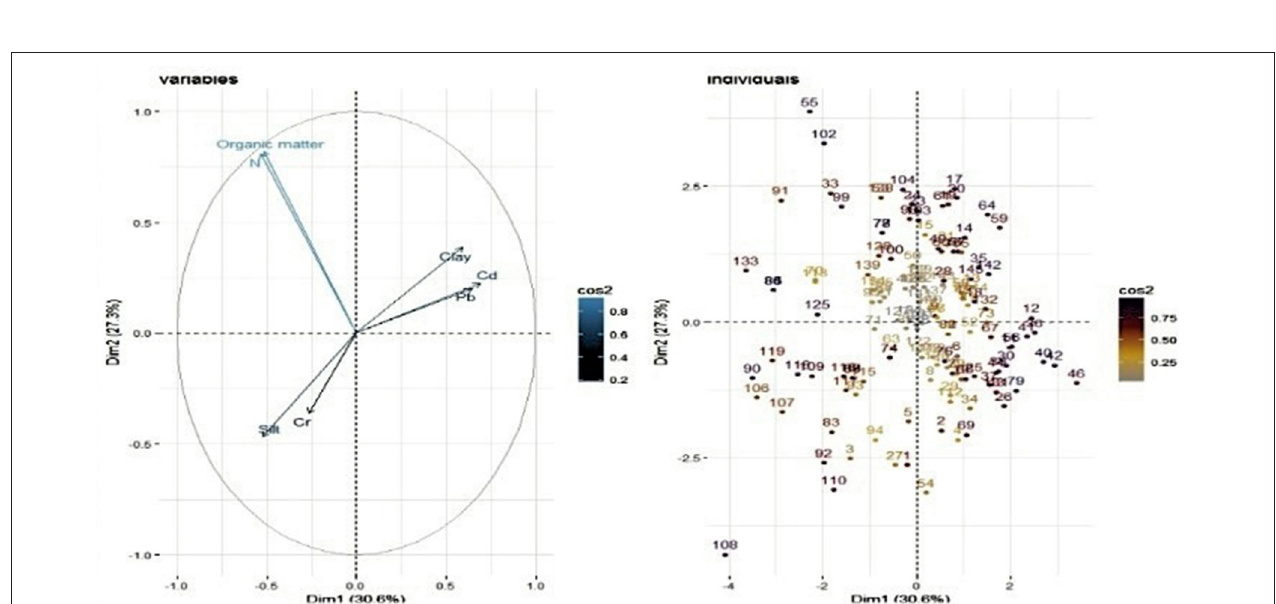
FIGURE 2 | Biplot showing representation of sampling points (called individuals) and physiochemical attributes (variables) in multivariate principal component space.